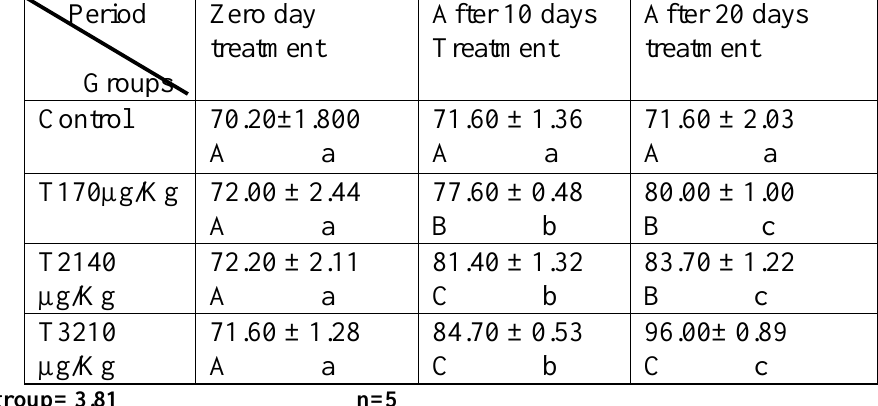
LSD group= 3.81 n=5 Values represent mean ±S.E Different capital letters mean significant results at (P<0.05) results between different groups. Different small letters mean significant results at (P< 0.05) between periods.